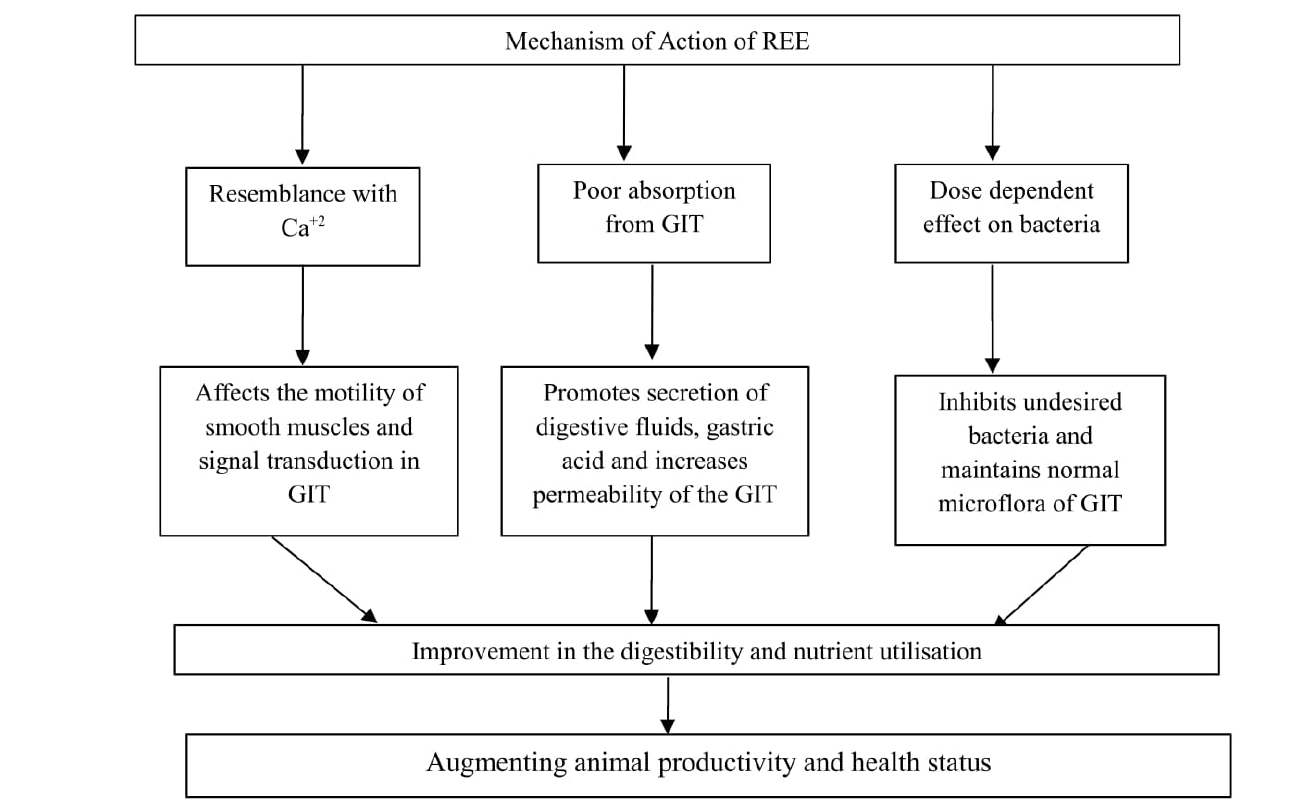
Figure 1. Proposed mechanism of action of rare earth element. REE, rare earth elements; GIT, gastrointestinal